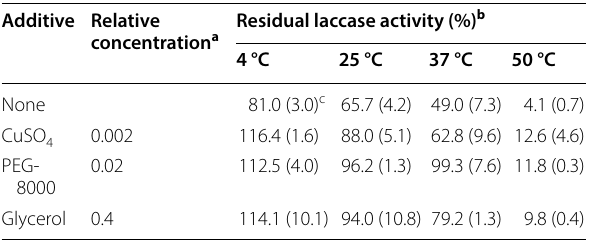
Table 5 Effect of additives used in the reaction mixture on laccase thermal stability in aqueous medium composed of acetate buffer (0.1 M, pH 5.0), using syringaldazine as